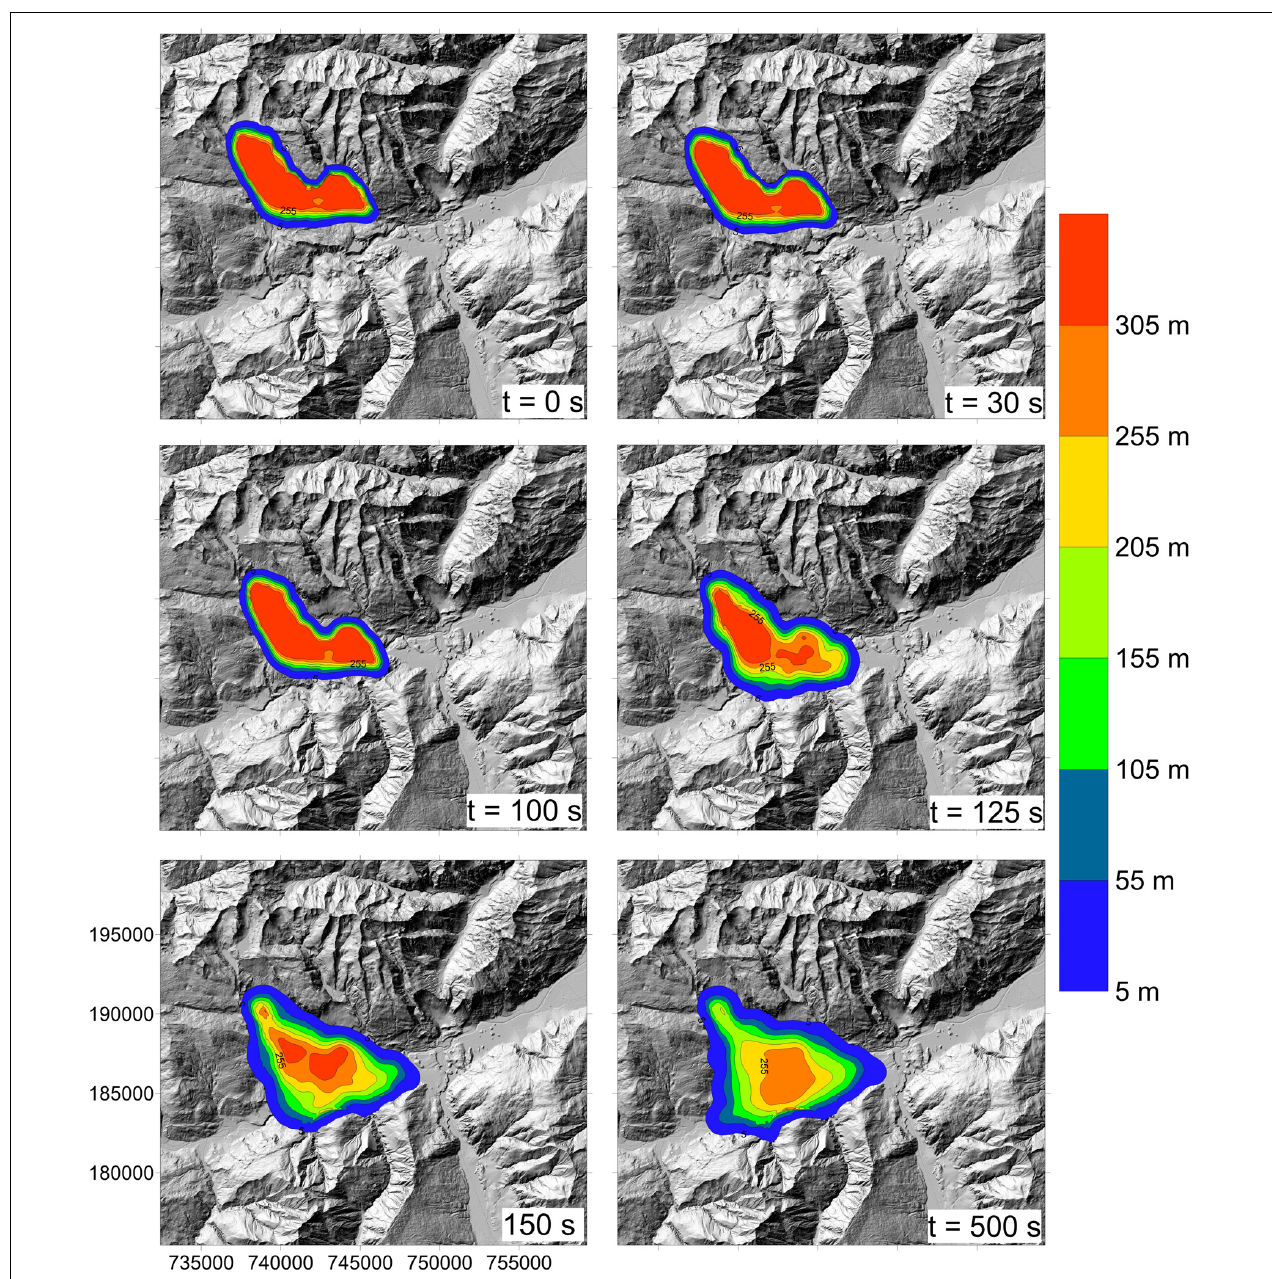
FIGURE 14 | Simulated deposit depths at different times during the simulation overlain on the post-event topography. The mass is specified to turn flow-like at 100 s.